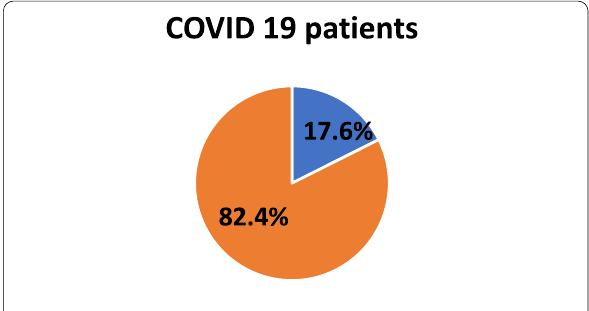
Fig. 1 Prevalence of chronic respiratory diseases among COVID-19 patients. Fifty-seven patients had comorbid chronic respiratory disease